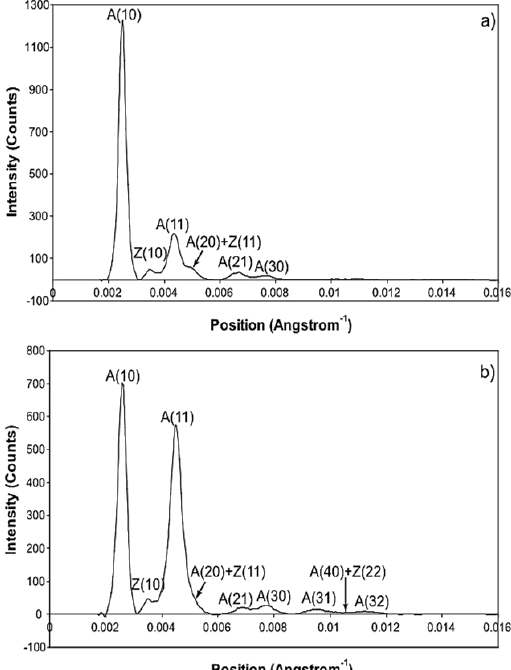
Figure 3. Equatorial profiles from the 100 ms relaxed and active frames of the summed time series with SL control. Both profiles were vertically integrated from 0.00125 Å −1 on either side of the equator. Data from 780 contractions were summed to produce the two profiles giving a total exposure time of 78 s. The background scatter was removed from the profiles to leave just the Bragg peaks by fitting a polynomial plus exponential function to it. (A: A-band peaks; Z: Z-band peaks). ( a ) Equatorial profile from the 100 ms relaxed frame. Six equatorial peaks are visible in the relaxed profile. ( b ) Equatorial profile from the 100 ms active frame. Nine equatorial peaks are visible in the active profile.